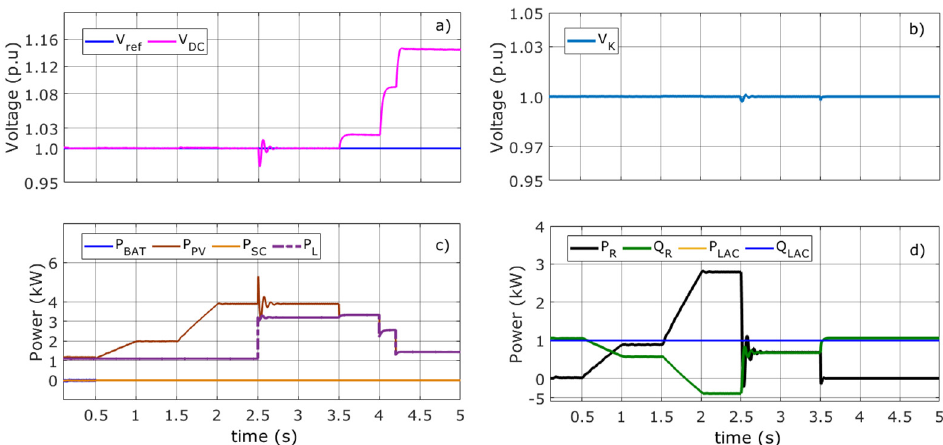
Figure 9. Voltage and power flow in Mode 4. ( a ) Reference and DC bus voltage ( b ) AC voltage ( c ) Battery, photovoltaic, SC, and load powers ( d ) Active and reactive VSC powers, active and reactive load powers.